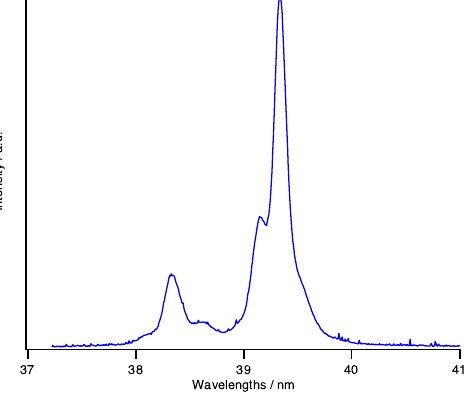
Figure 6. Sum of spectra with 3rd grating order of color 2 (12.78 nm/97 eV) and 4th grating order of color 1 (9.83 nm/126.13 eV). The photon beam intensity relation was due to experimental needs during the two-color test